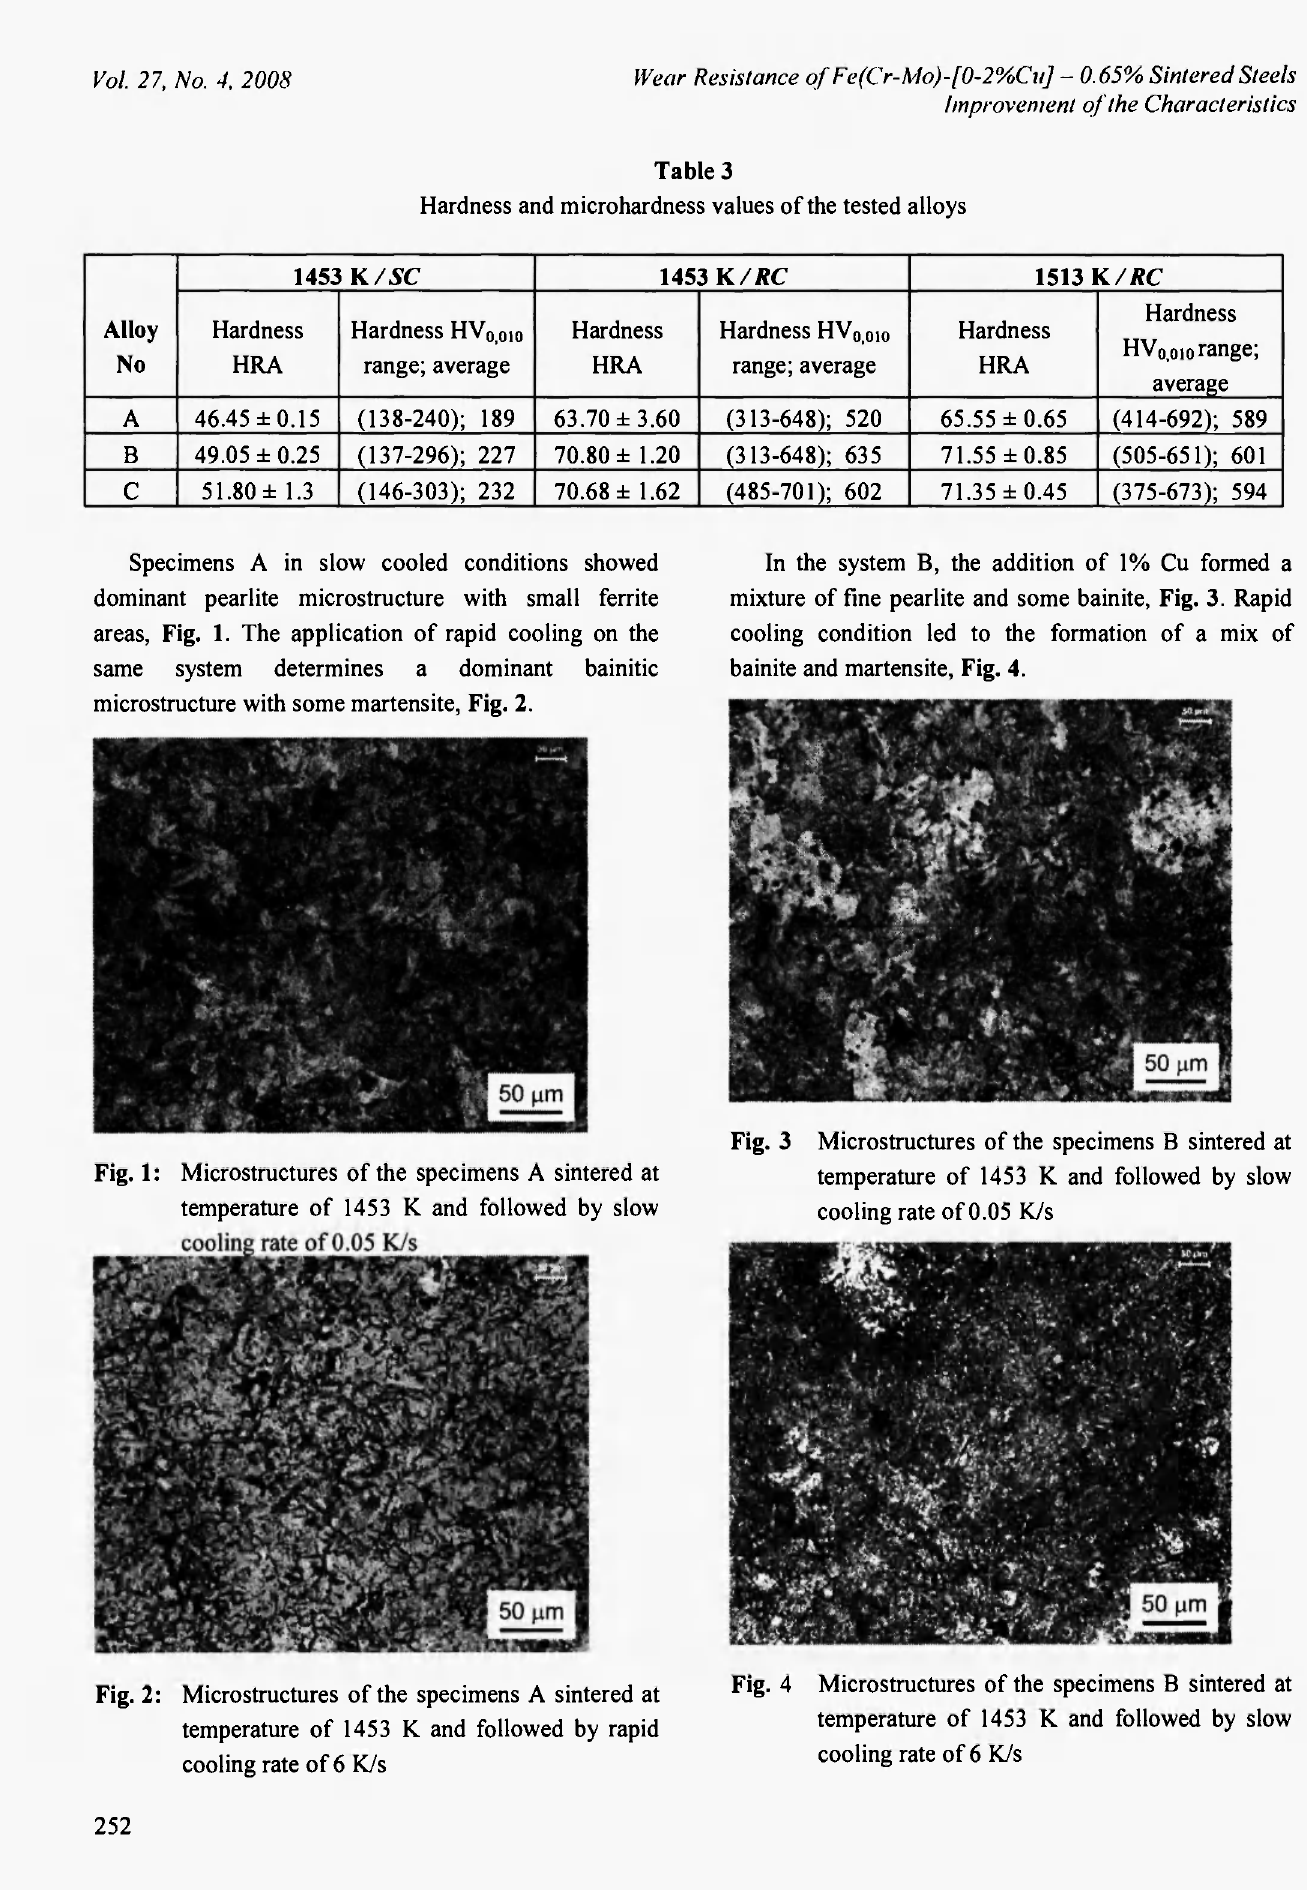
Fig. 2: Microstructures of the specimens A sintered at temperature of 1453 Κ and followed by rapid cooling rate of 6 K/s